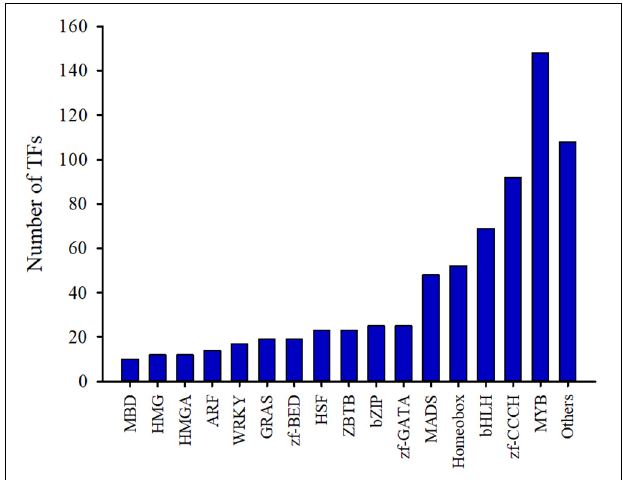
FIGURE 2 | Identification of transcription factors (TFs) from C . sinense